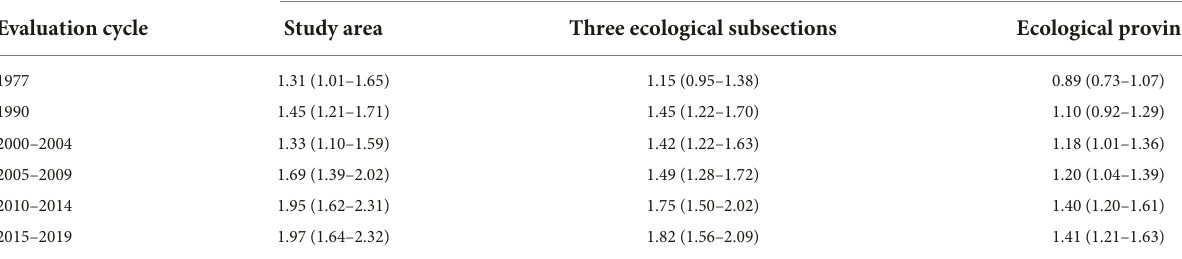
TABLE 2 Estimates of the density (85% Credible Intervals) of tree stems with cavities suitable for nesting wood ducks in the forested portion of Minnesota during six forest inventory and analysis evaluation cycles. Density estimates at three spatial